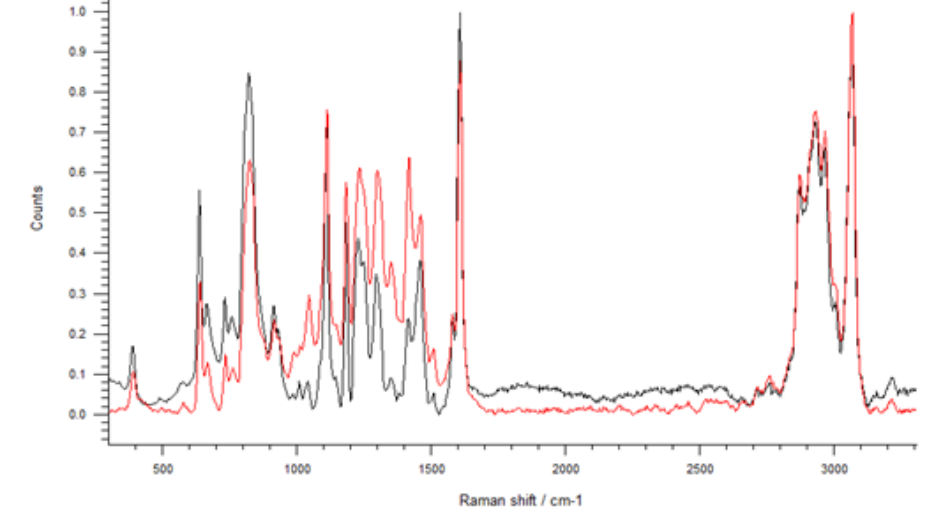
Figure 13. Raman spectrum of epoxy resin at 2000 rpm before and after aging in sulfuric acid .